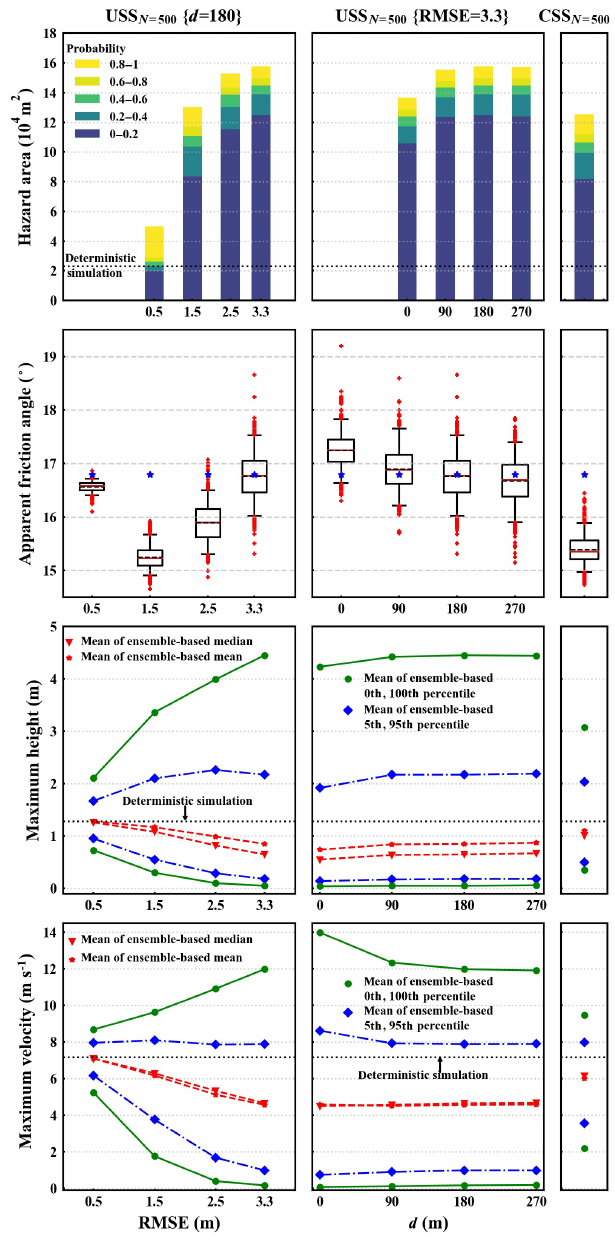
Figure 11. Consolidated results of all ensembles. The left, middle, and right columns correspond to the set of USS N = 500 {RMSE = 0 . 5, 1.5, 2.5, 3.3, d = 180} ensembles, set of USS N = 500 {RMSE = 3 . 3, d = 0, 90, 180, 270} ensembles, and CSS N = 500 ensemble, re- spectively. The first row shows stacked bar plots of the potential hazard area’s magnitude based on the probabilistic hazard map for each ensemble (see Fig. 8a and c). The second row shows appar- ent friction angle distribution. The last two rows show statistics of maximum height and maximum velocity at channel bottom loca- tions (see Fig.